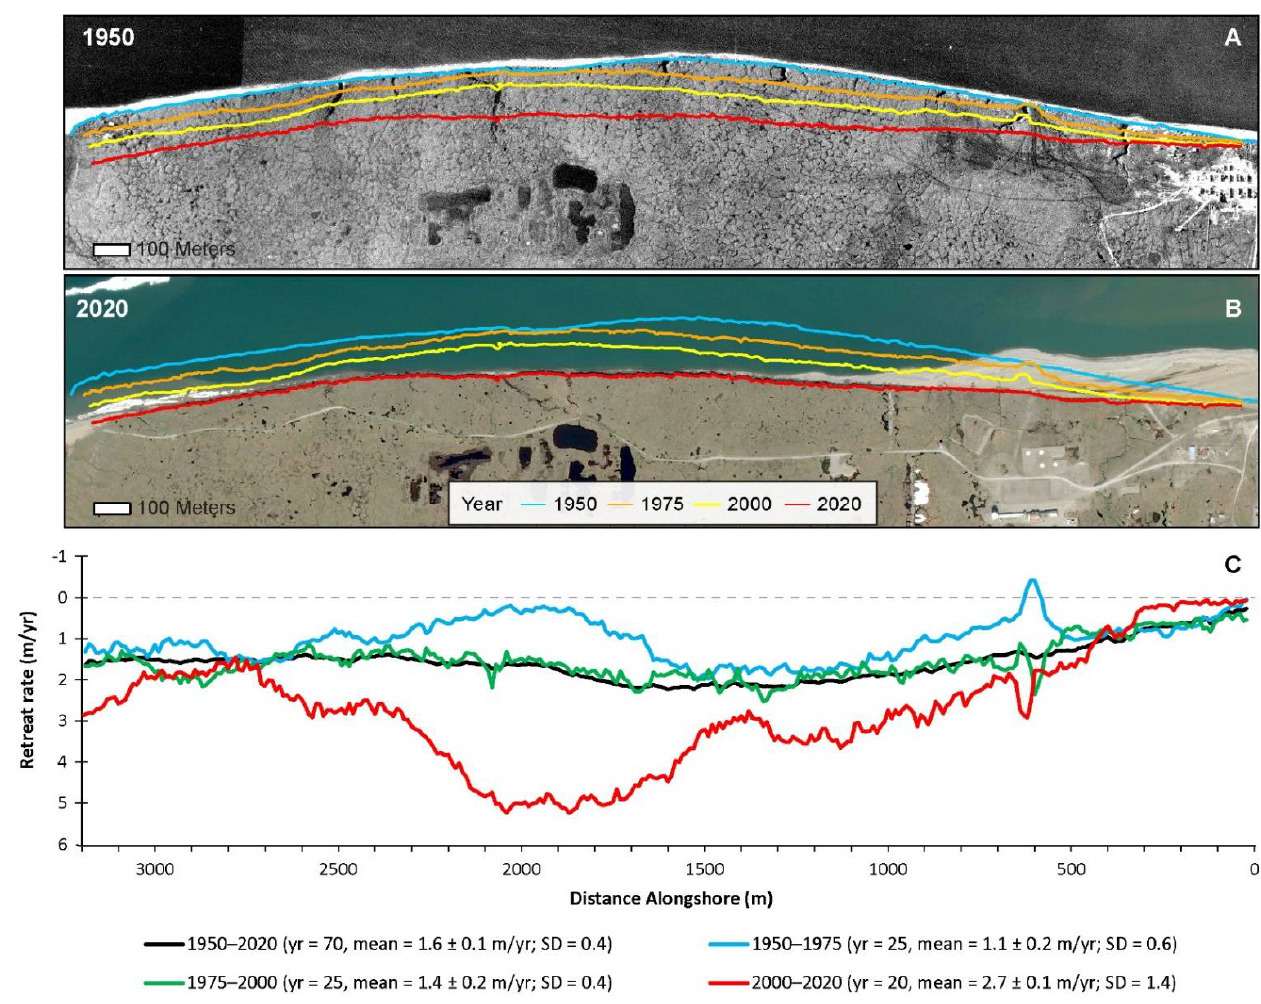
Figure 5. Rates and patterns of bluff change at Barter Island from 1950 to 2020. ( A , B ) show the same extent with bluff edge positions from 4 years overlain on images from 1950 and 2020, respectively. ( C ) is the same alongshore extent, with the mean decadal rate of change at each transect location plotted. The black line is the long-term 70 year mean. The record is entirely erosional except for a small extent of accretion between 1950 and 1979 associated with the construction of a landfill at the radar station. Between 2000 and 2020, retreat rates were substantially higher than the previous 25 year time periods and the rate of change on the easternmost side of the bluffs approaches 0 as a relatively persistent beach formed, providing protection to the coastal bluffs from seasonal wave attack. Imagery base is Alaska High Resolution Imagery RGB (https://gis.data.alaska.gov/pages/Imagery%20Program accessed on 1 October 2021).